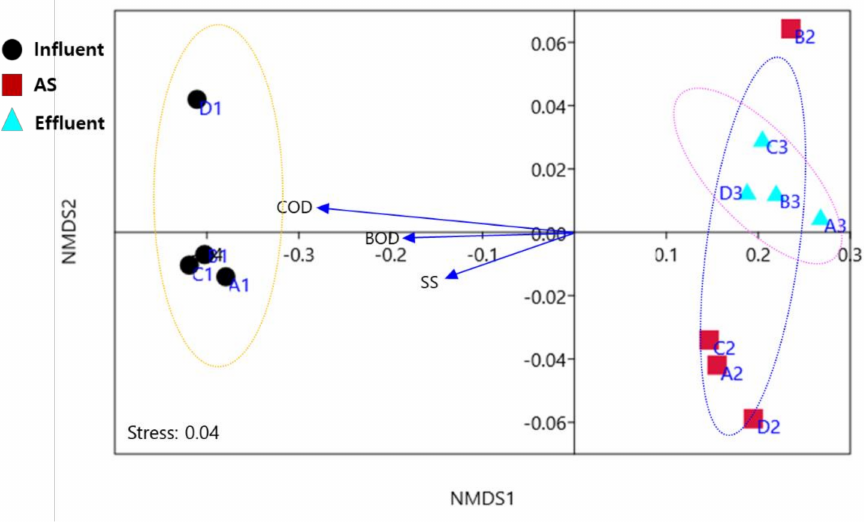
Figure 3. Nonmetric multidimensional scaling (NMDS) of ARG distribution patterns between small (A, B) and large (C, D) WWTP samples. A1, B1, and C1 indicate influent samples, A2, B2, and C2 indicate activated sludge samples, and A3, B3, C3 indicate effluent samples. Stress is a nonnegative number, representing the credibility of the cluster results. A stress value <0.3 indicates high confidence. Blue arrows indicate significant positive correlation parameters (r > 0.6, p < 0.05). The most dominant genera also showed similar patterns among sample types (Figure